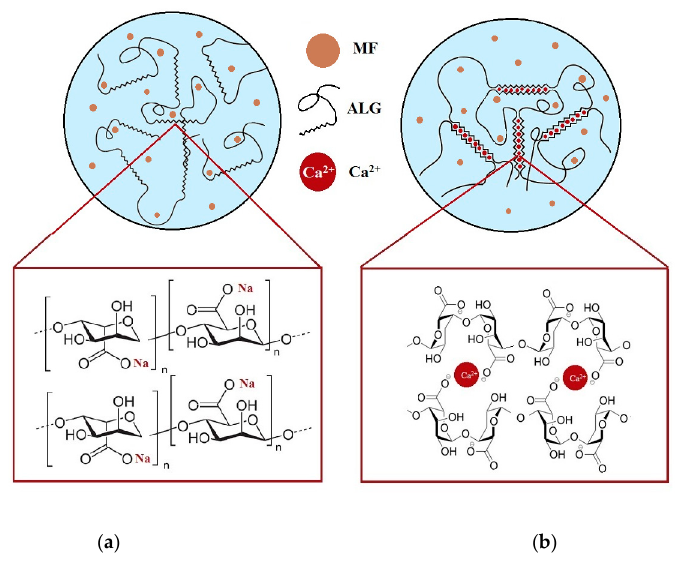
Figure 1. Structure of non-modified ( a ) and CaCl 2 cross-linked ( b ) ALG microparticles containing MF.